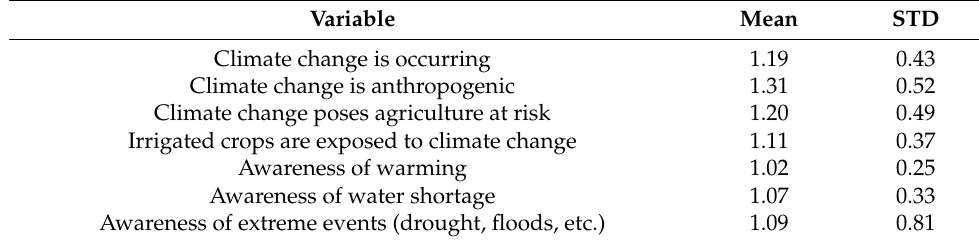
Table 3. Descriptive statistics of climate change